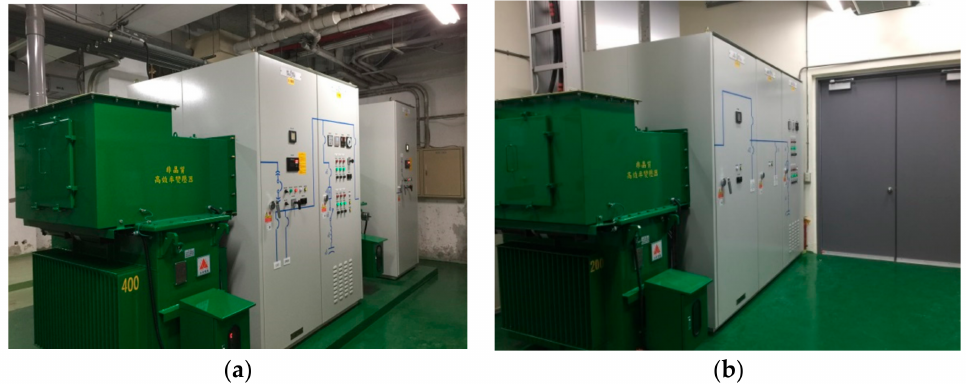
Figure 18. New power substation in Taiwan Tech: ( a ) library; ( b ) T3